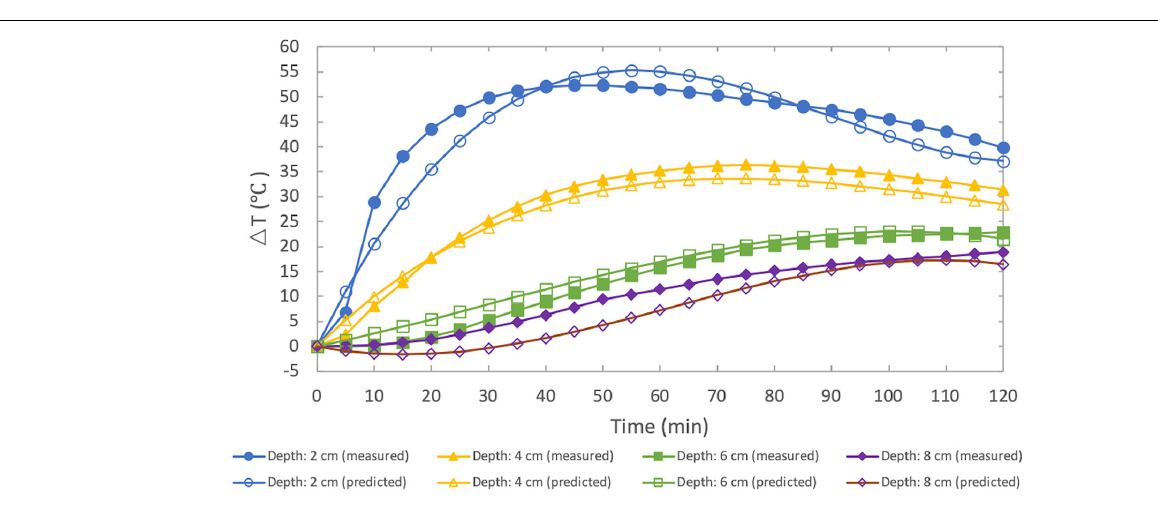
FIGURE 3 | (cid:49) T curves at (A) 2 cm, (B) 4 cm, (C) 6 cm, (D) 8 cm, and (E) 12 cm.